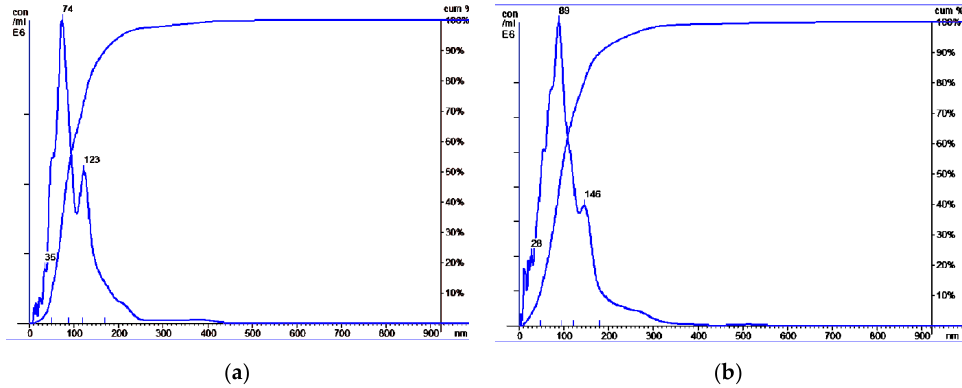
Figure 2. Size distribution of plasma exosomes isolated from the blood of HFs and BCPs. Data of NTA analysis (Malvern, NS-300). ( a ) Exosomes from blood plasma of HFs; ( b ) exosomes from blood plasma of BCPs.